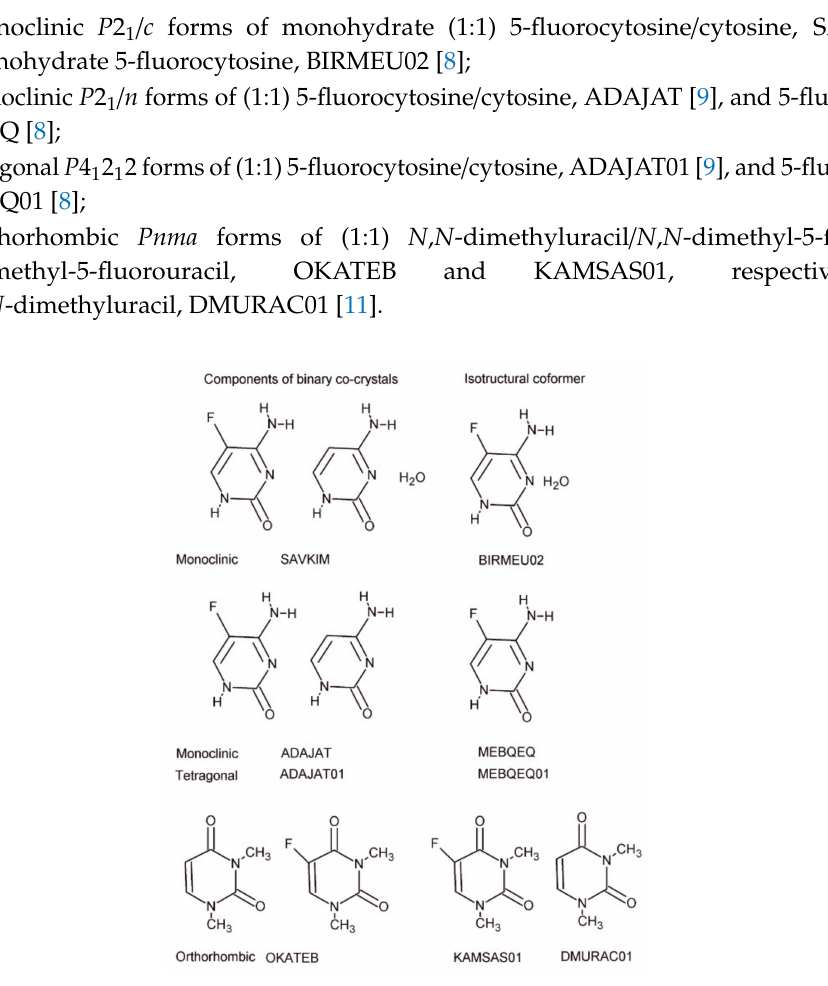
derivatives showing crystal packing similarity with unsubstituted and 5-fluorosubstituted